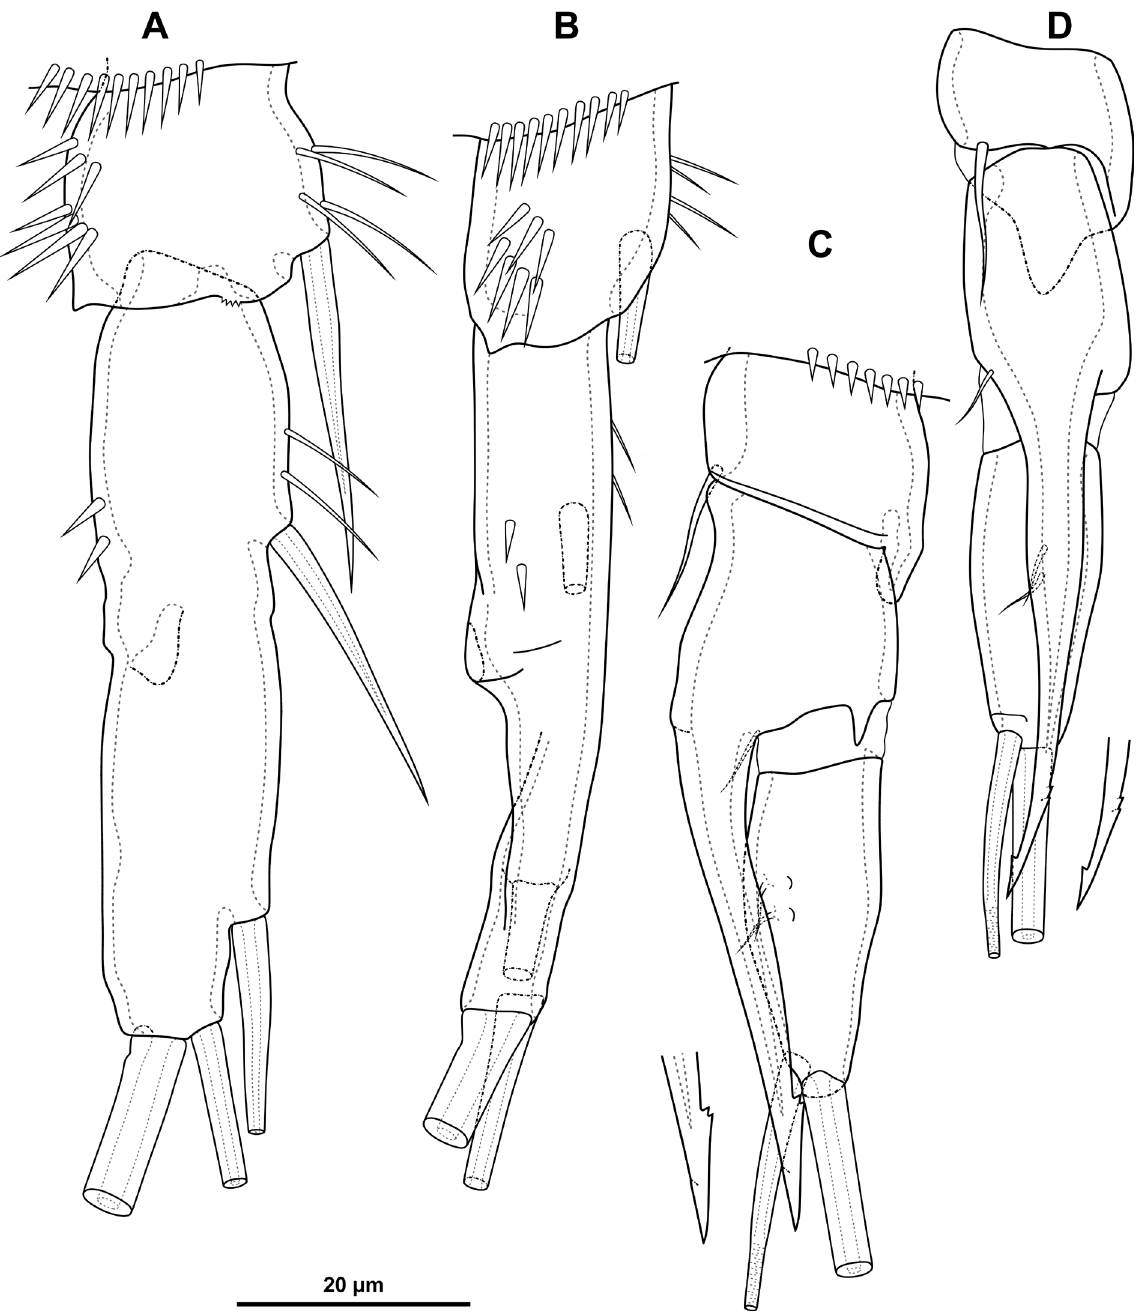
Fig. 10. Canthocamptus waldemarschneideri sp. nov., ♂, Yuzshnoe Lake (KFU). A . P2 endopod, anterior view. B . P2 endopod, outer side. C . P3 endopod, anterior view. D . P3 endopod, inner